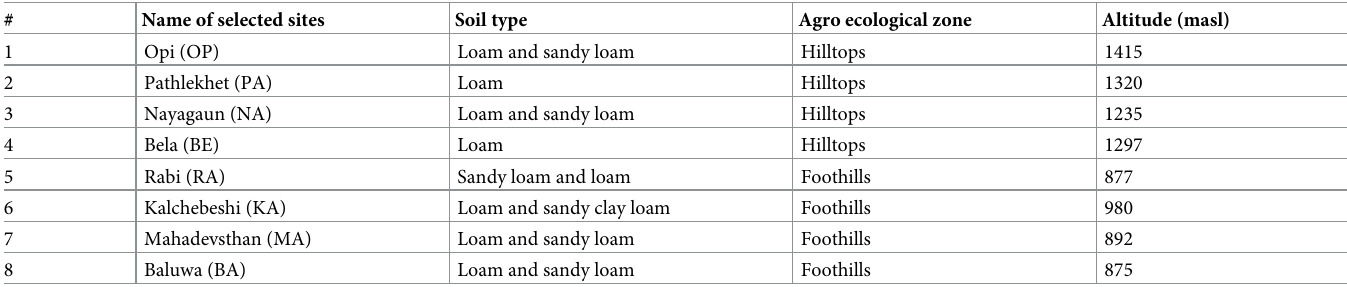
Table 2. Description of the eight study sites at